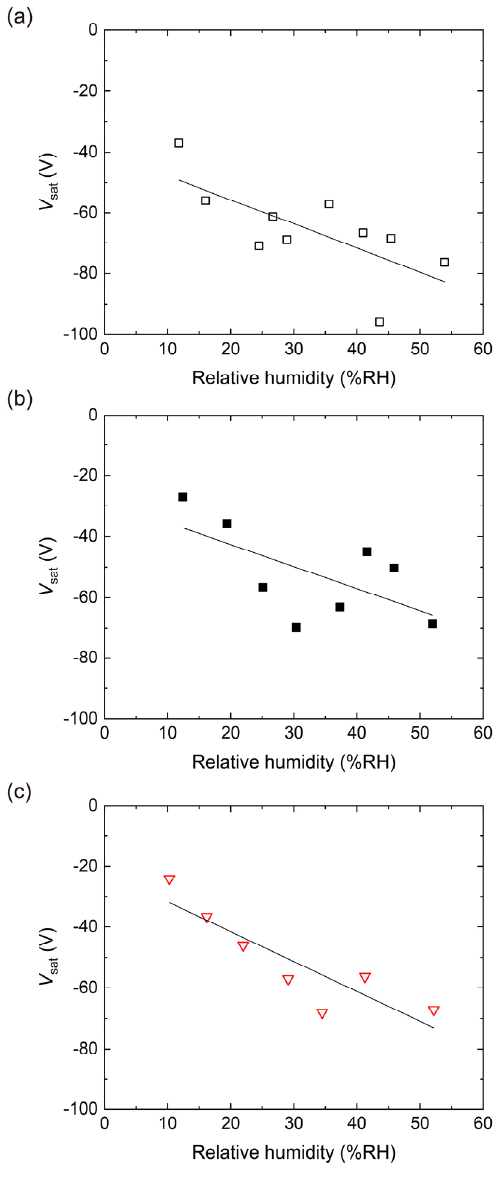
Figure 9. Plots of V sat versus relative humidity for PES films doped with 1 wt% ( a ), 5 wt% ( b ), and 10 wt% ( c ) P25mix nanoparticles.